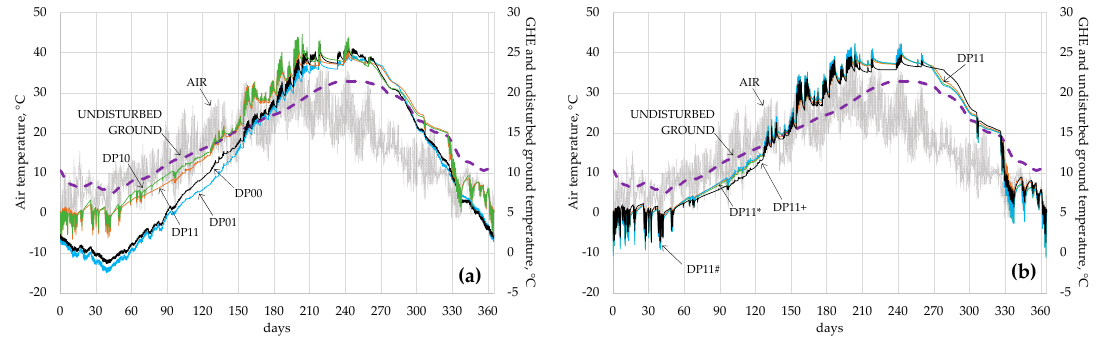
Figure 8. Annual trend of temperatures ( a ) for cases DP00, DP01, DP10, DP11 and ( b ) DP11, DP11*, DP11#, DP11+.